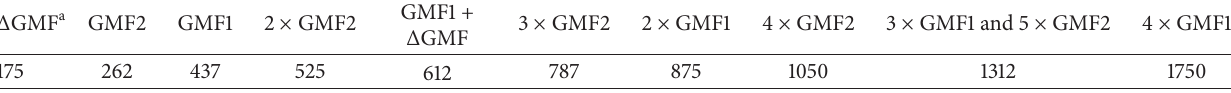
Table 2: Expected frequencies (Hz) from gearbox operating at 820